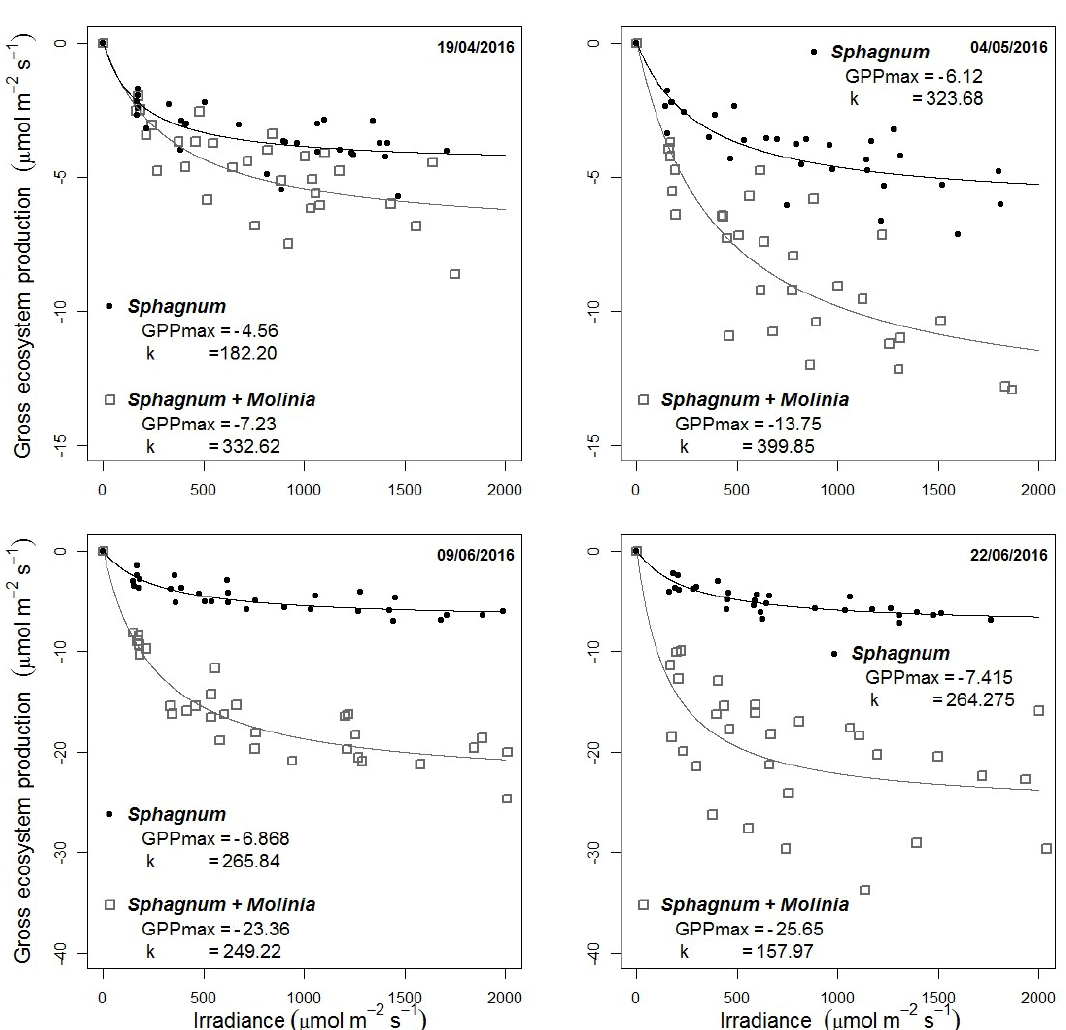
Figure 2. Dependence of gross primary production (GPP) on PPFD on four dates. The photosynthesis–PPFD curve shows the maximum rate of photosynthesis (GPP max ) and the half-saturation value ( k